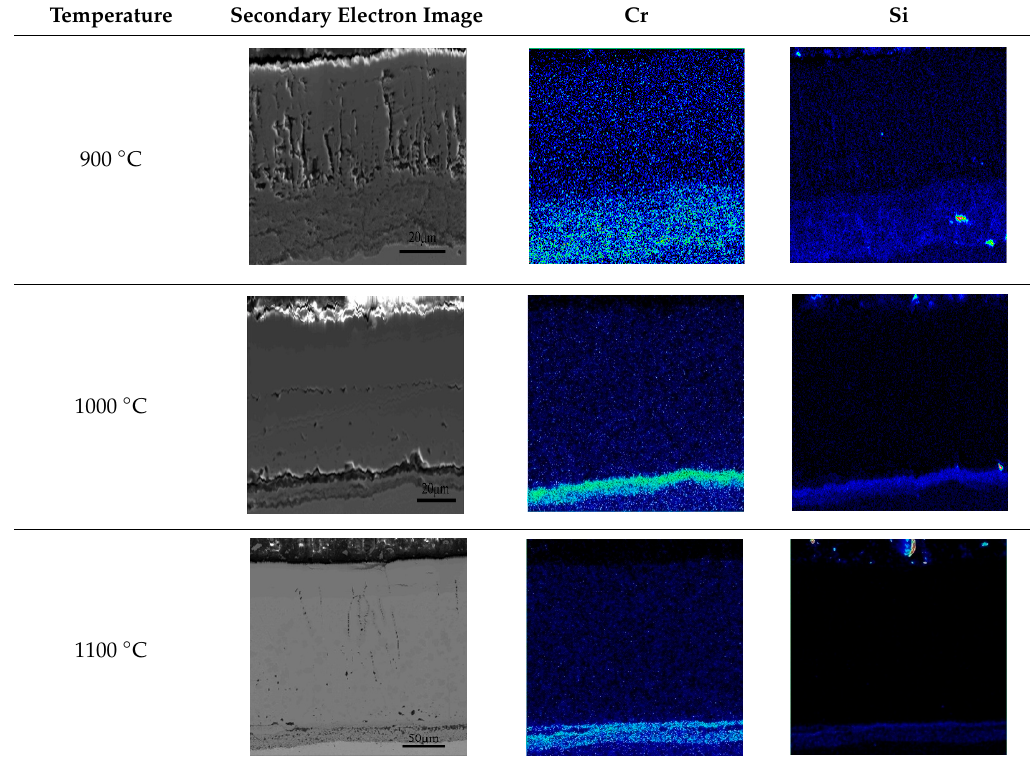
Table 4. EDS elemental maps obtained from the cross-section of the Fe–1Cr–0.2Si steel oxidized at di ff erent temperatures.